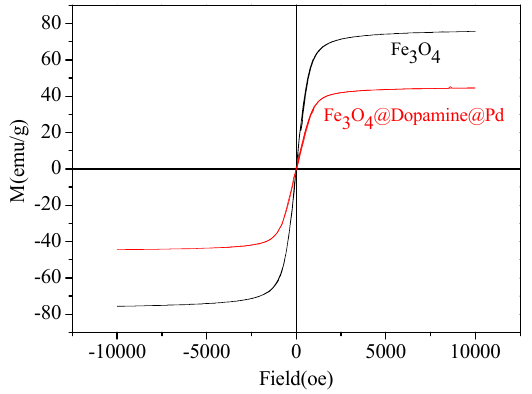
Figure 4. Magnetization curves of Fe 3 O 4 and Fe 3 O 4 @PDA@Pd.